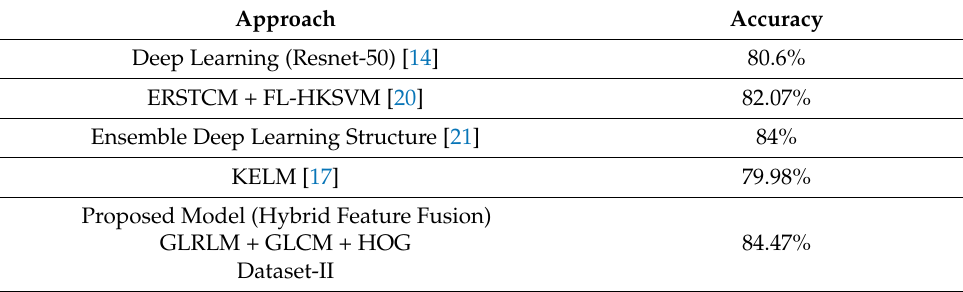
Table 14. Comparison between the proposed method with the existing